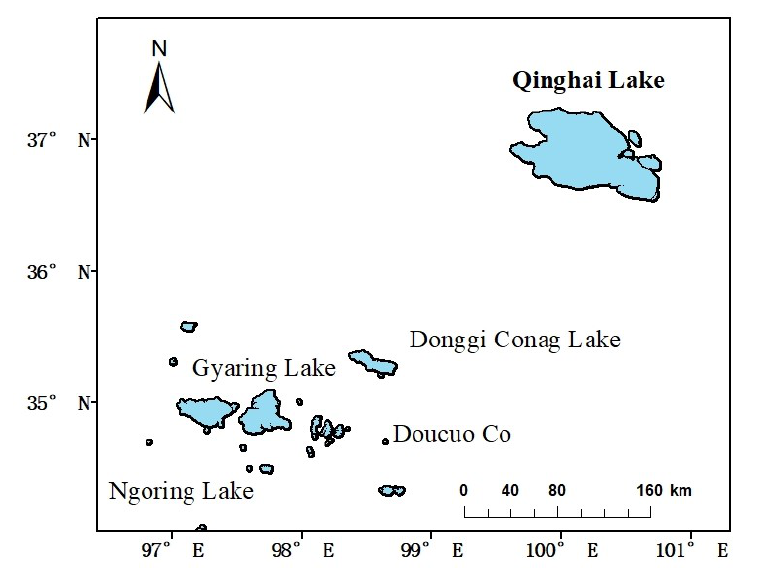
Figure 4. The study area includes Qinghai Lake, Ngoring Lake, Gyaring Lake, Donggi Conag Lake, and several wetlands and estuaries. These places serve as a critical breeding ground and migratory staging area for Bar-headed